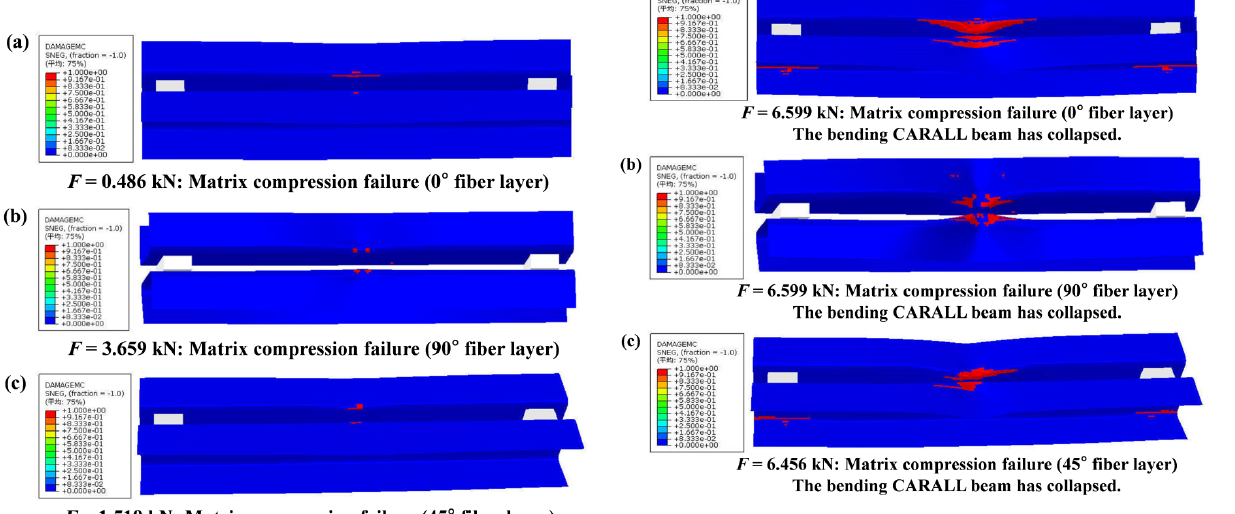
Figure 19: Matrix tensile failure area distribution of fiber layers in final failure state: (a) SHCXL-A: 0 ∘ fiber layer; (b) SHCXL-A: 90 ∘ fiber layer; and (c) SHCXL-B: 45 ∘ fiber layer.